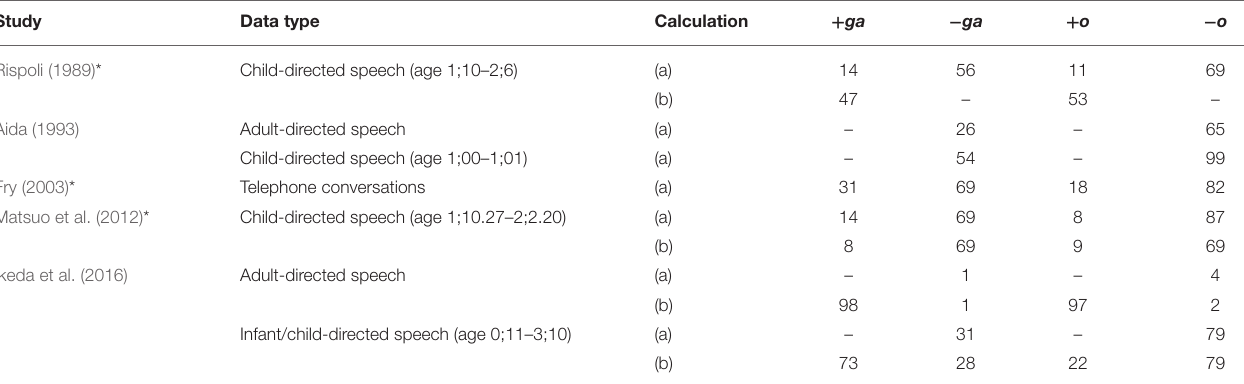
TABLE 3 | Previous findings of overt and omitted case marker rates (%) in Japanese ( + ga/o indicates the presence of the nominative/accusative markers and − ga / o indicates the omission of the nominative/accusative